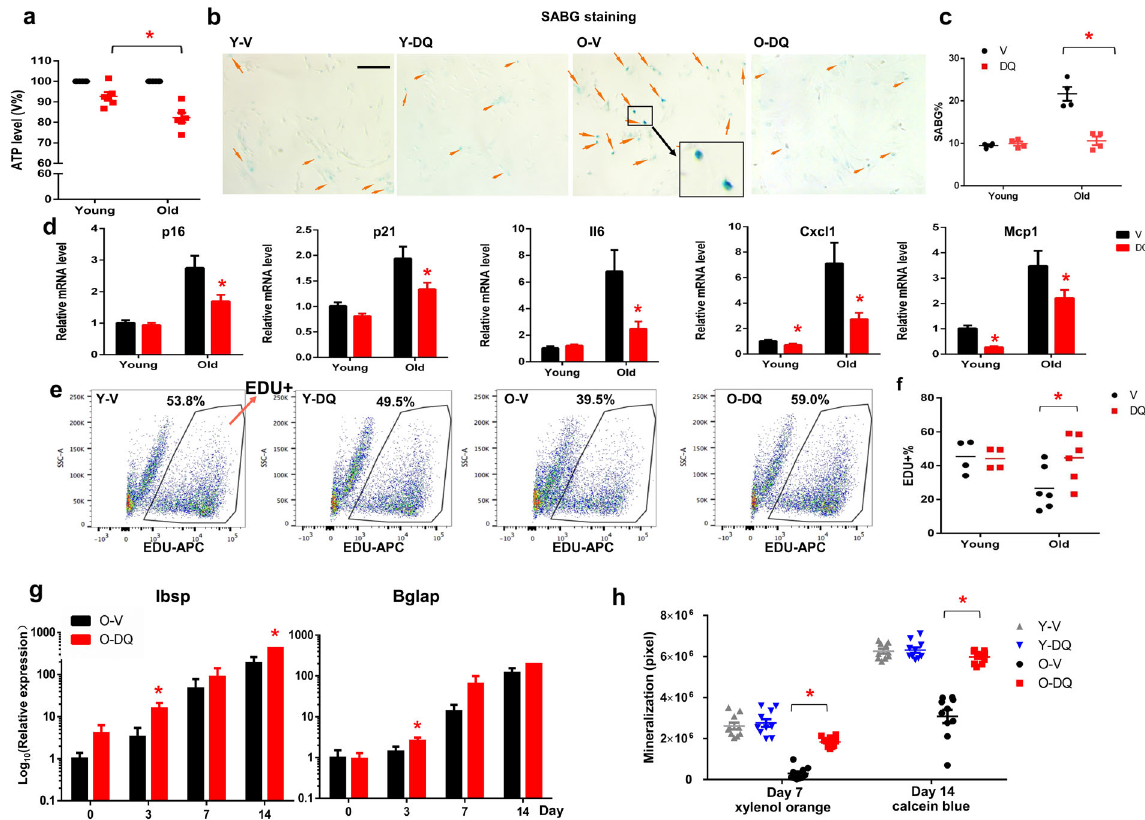
Fig. 1 D + Q improved proliferation and osteogenic capacity of old BMSCs in vitro. a ATP assay of young and Old V or DQ treated BMSCs. n = 6 for both groups. b Representative images of senescence-associated β -gal (SABG) staining. Scale bar: 50 μ m ( c ) Percentage of SABG positive cells. n = 4 for both groups. d Expression of p16, p21, Il6, Cxcl1, MCP1 was analyzed by real-time PCR at day 0. n = 10 (male and female donors combined) for both groups. e FACS analysis on EDU + cells. f Percentage of EDU + cells of the total cells. n = 4 for young groups and n = 6 for old groups. g Expression of Ibsp and Bglap was analyzed by real-time PCR at day 0, 3, 7, and 14 after the exposure to osteogenic media. n = 6 for both groups. h Old V or DQ treated BMSCs were differentiated in osteogenic media. The same wells were stained with xylenol orange at day 7 and calcein blue at day 14 to quantify the mineralization area at both time points. n = 10 (male and female donors combined) for both groups. Results were shown as means ± s.e.m. * p < 0.05; two-tailed Student ’ s